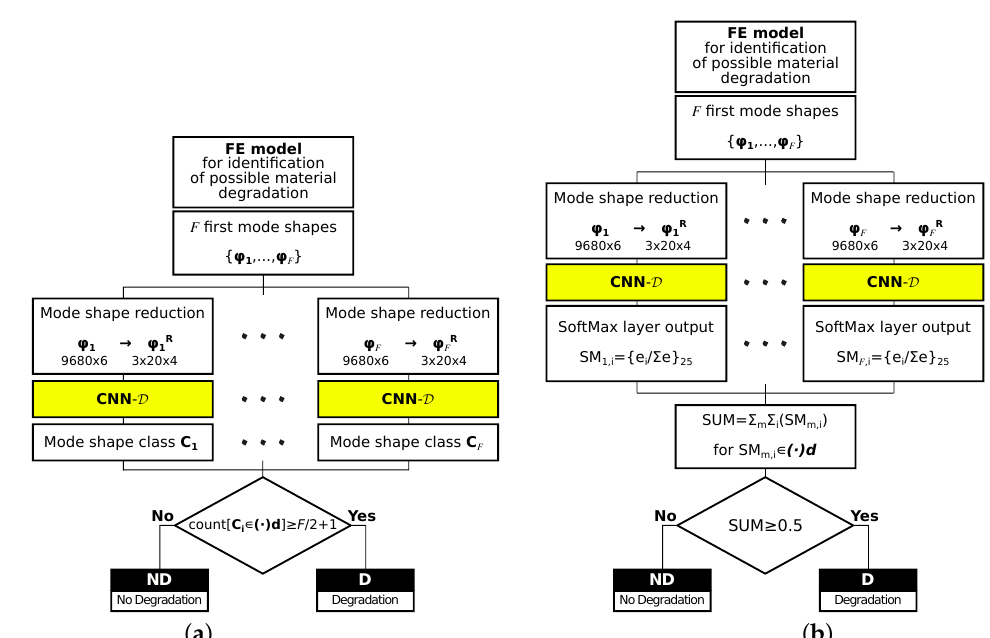
Figure 11. Identification of models with material degradation: ( a ) counting approach (CA), ( b ) probability approach (PA).